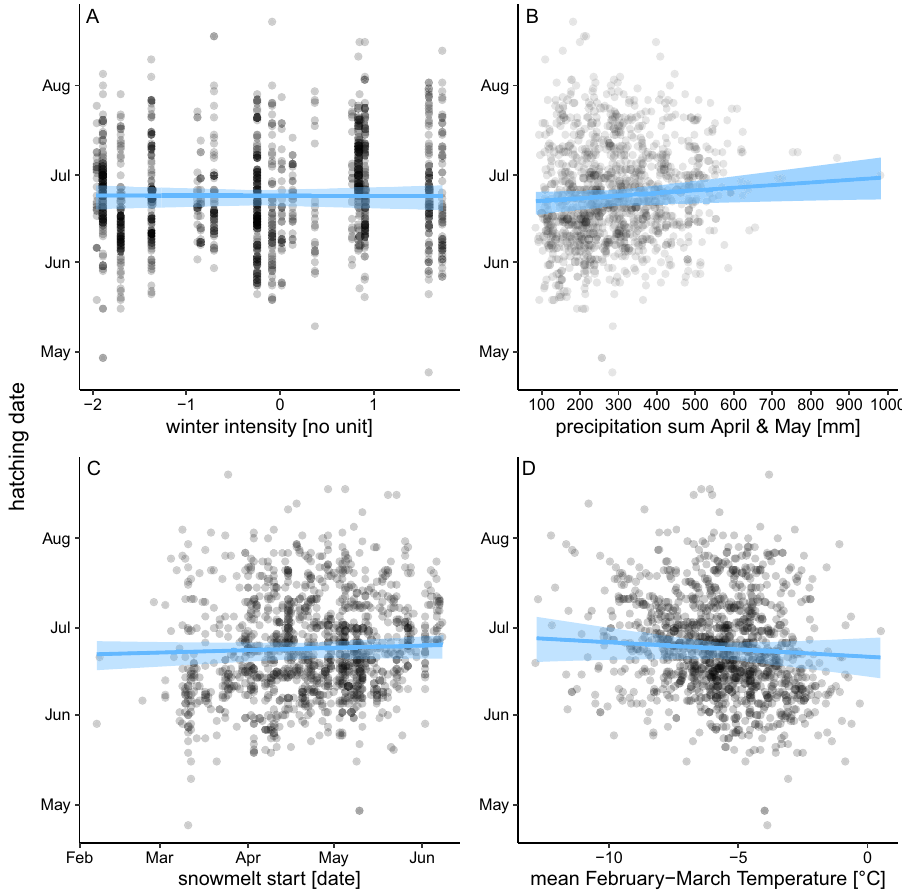
Figure 4. Hatching date of snowfinches in relation to partial effect sizes of winter intensity (A) , precipitation (B) , snowmelt initiation (C) and temperature (D) as estimated from a model including both spatiotemporal and environmental predictors. Blue polygons show Bayesian 95% compatibility